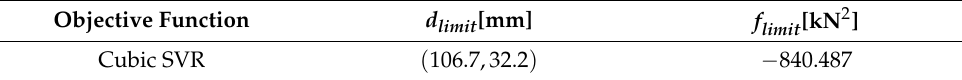
Table 7. The found optimum of the fitted SVR metamodel for the discrete variable domain.